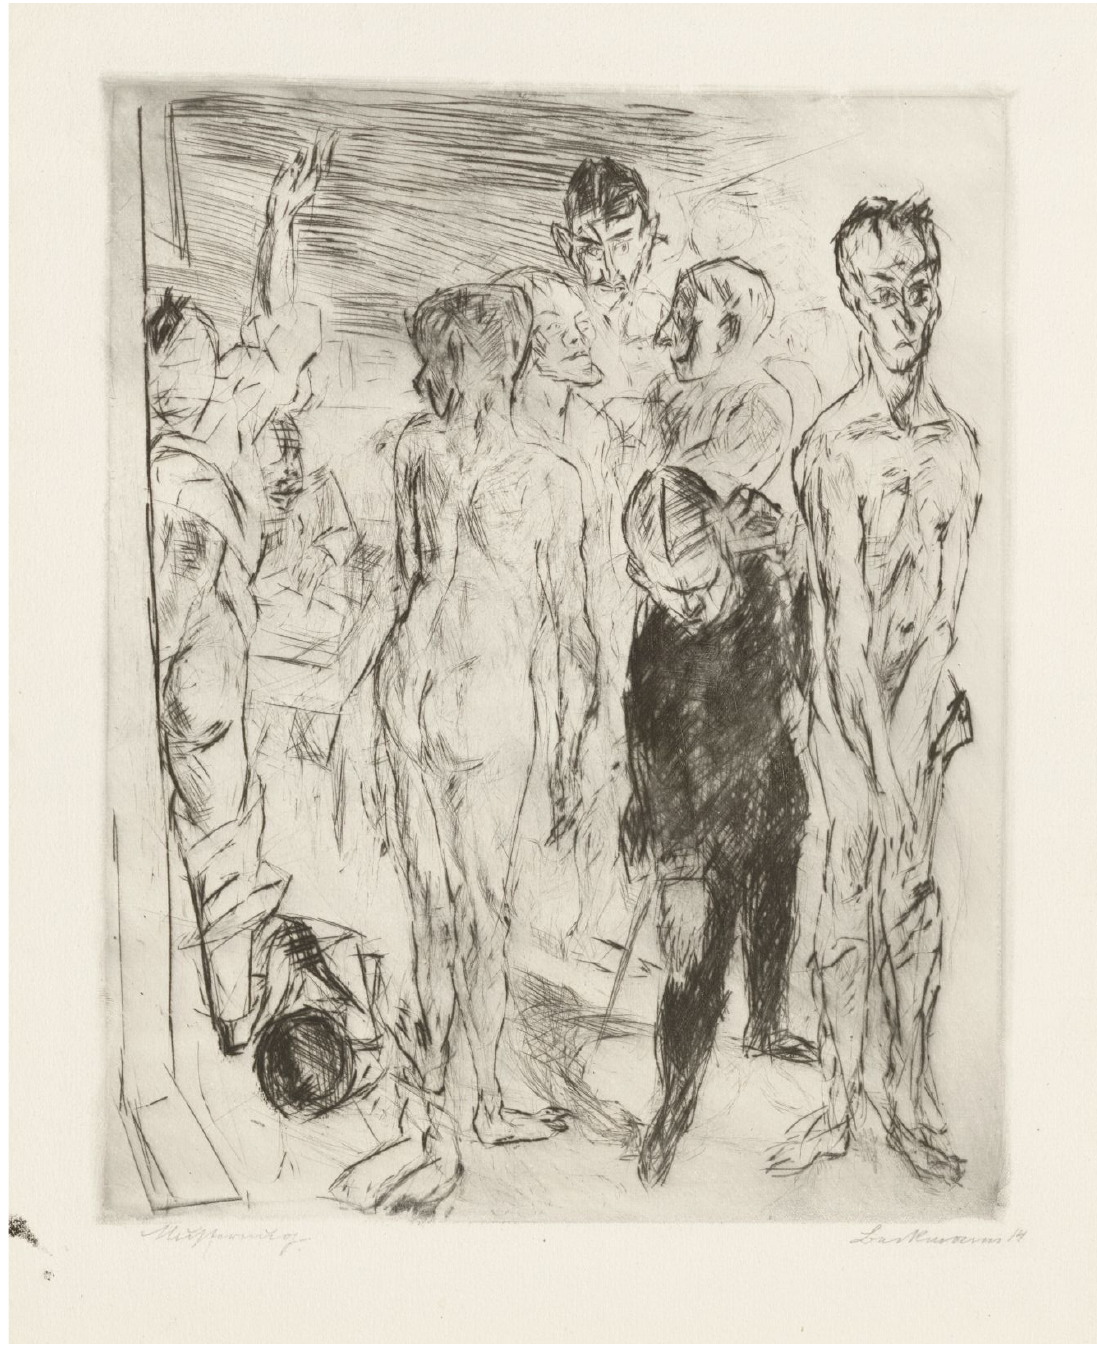
Figure 7 Max Beckmann, Musterung (Muster). 1914; printed by Paul Cassirer Verlag in 1918. Etching and drypoint on etching board. Collection of the Sprengel Museum Hannover. 29.6 x 23.7 cm. Photo: Michael Herling/Aline Gwose. © 2012 Artists Rights Society (ARS), New York/VG Bild-Kunst,